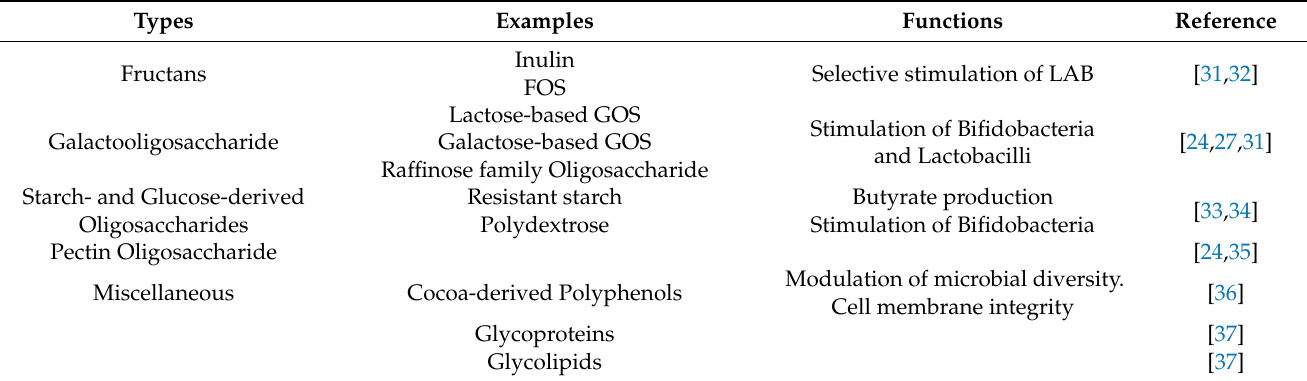
Table 1. Types of